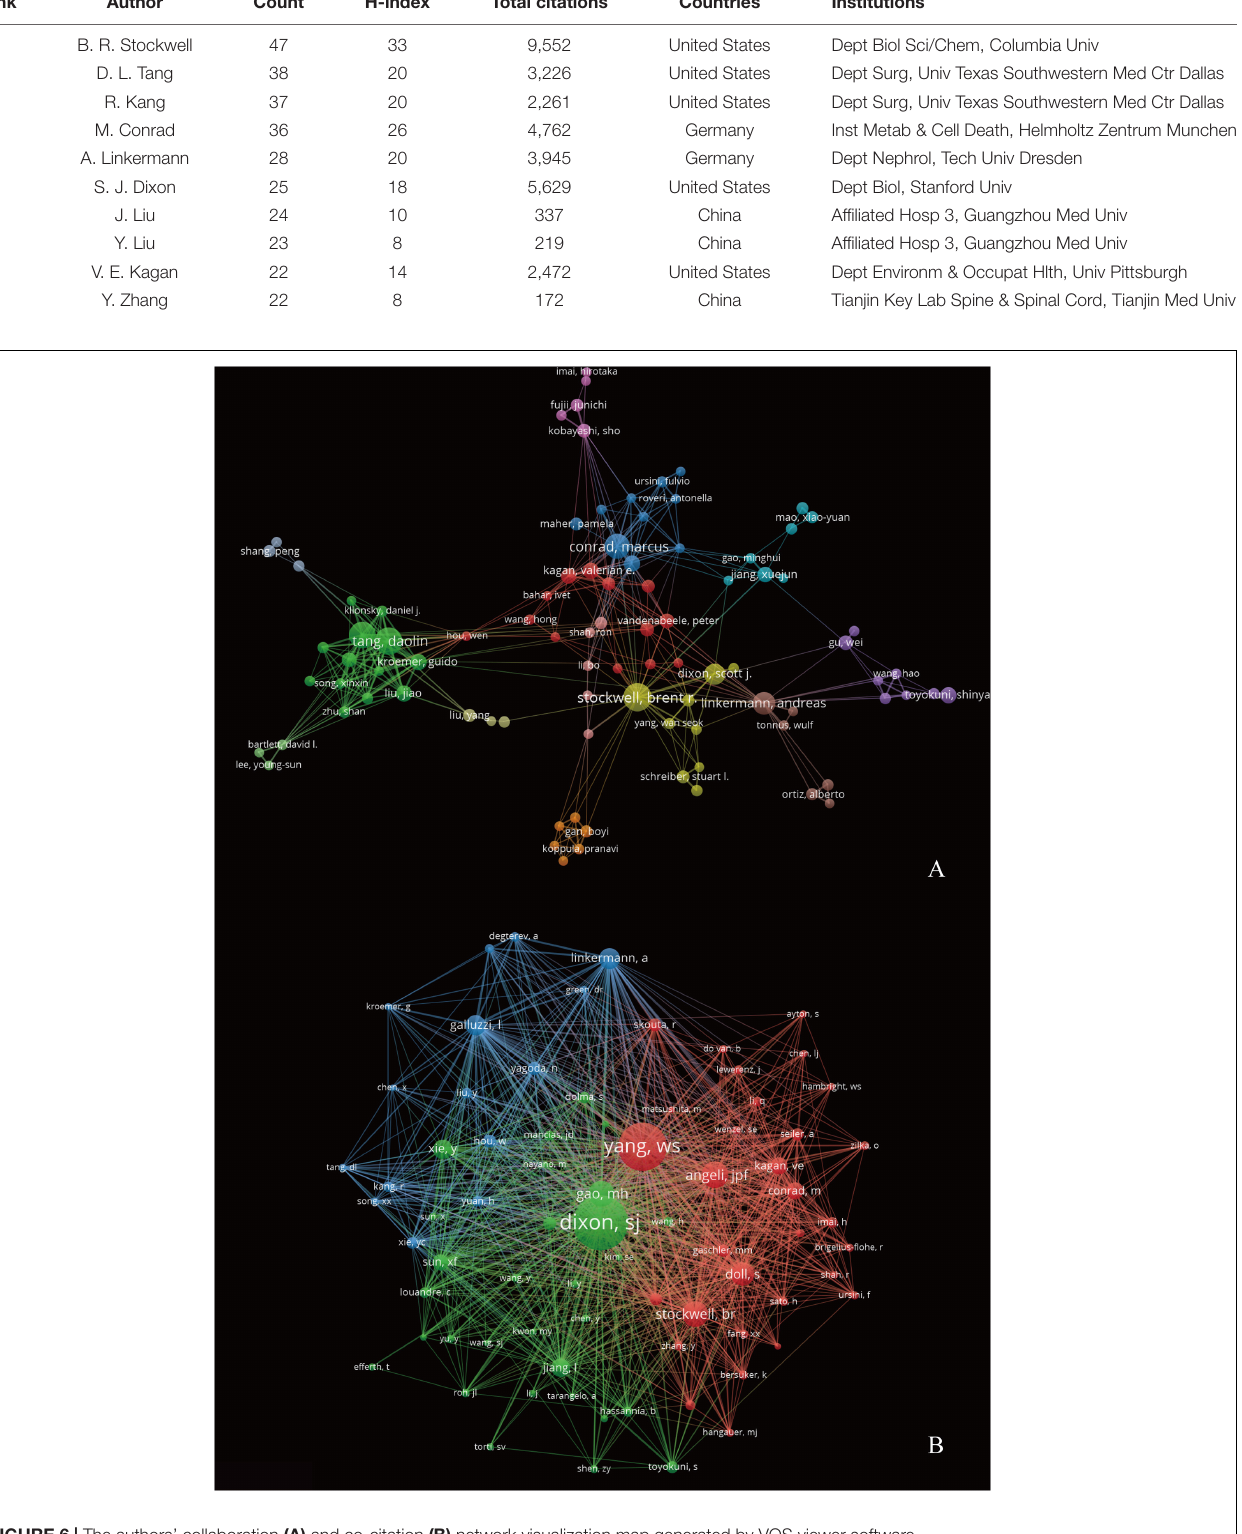
FIGURE 6 | The authors’ collaboration (A) and co-citation (B) network visualization map generated by VOS viewer software.